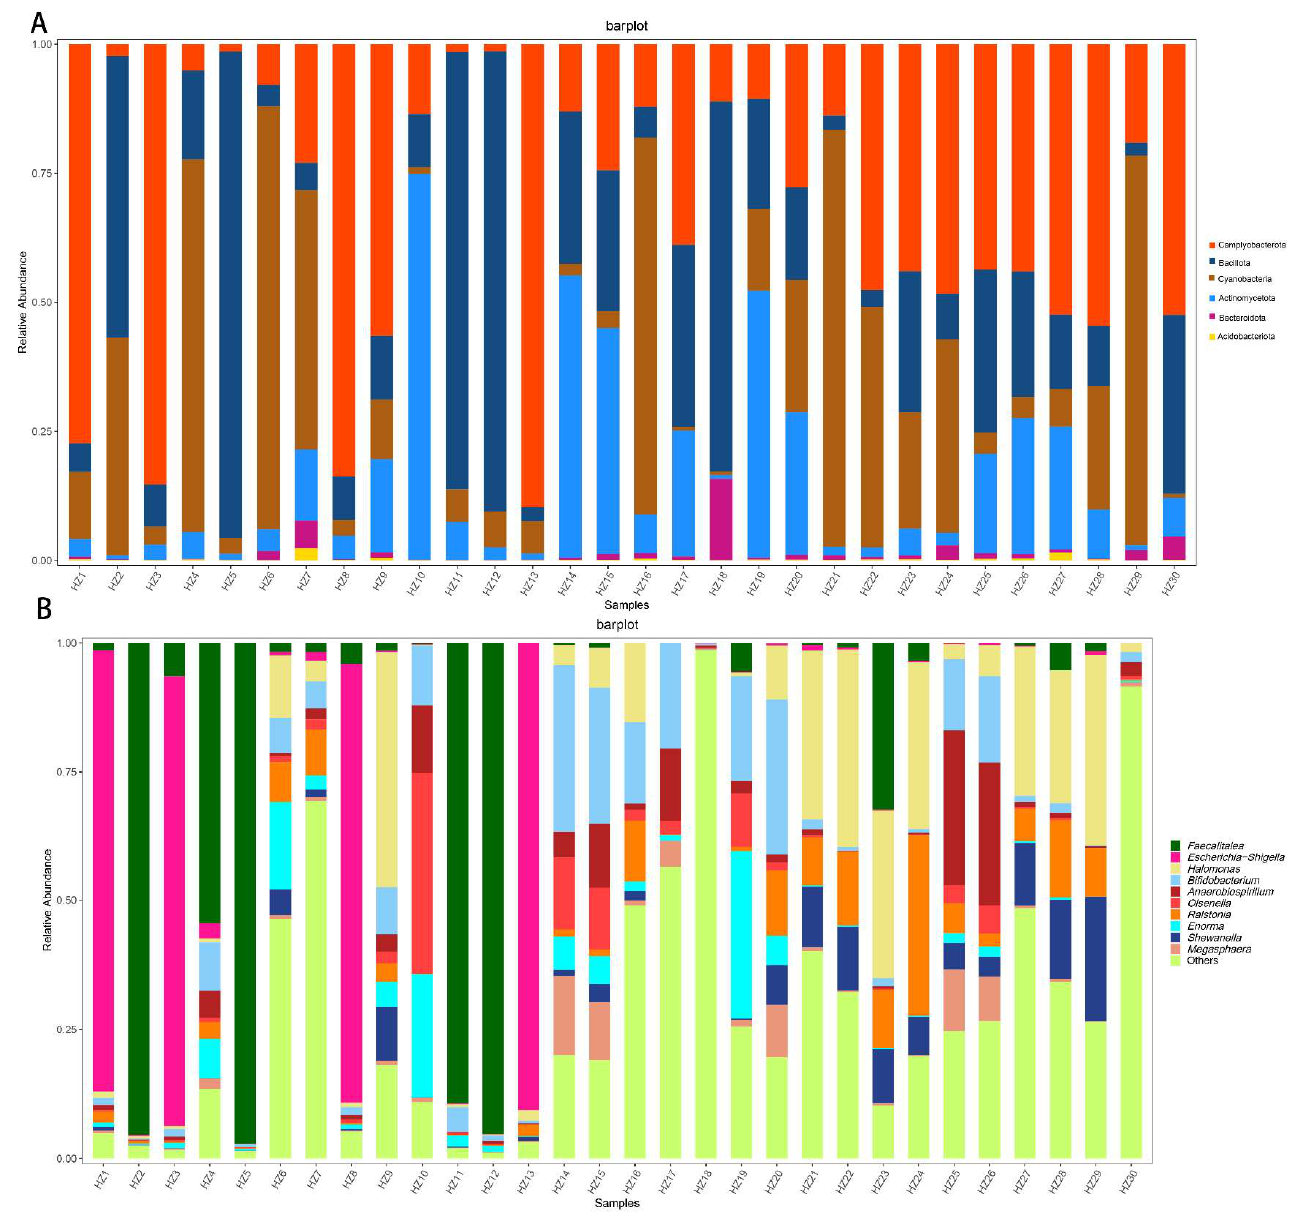
Figure 4. Gut microbiome composition between five wild black-billed capercaillie flocks at the phy- lum ( A ) and genus ( B ) levels. The abscissa represents the black-billed capercaillie samples, and the ordinate represents the relative abundance of fecal bacteria.